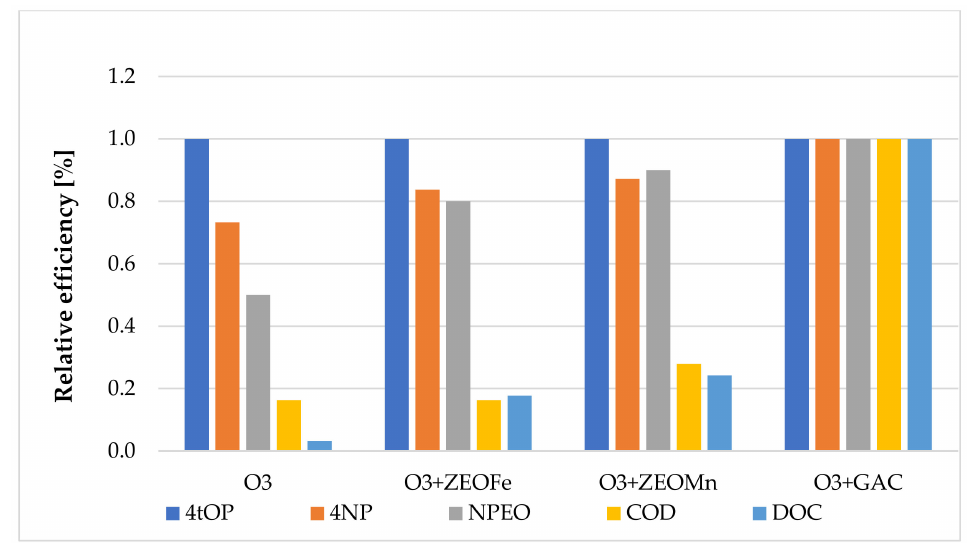
Figure 5. Relative efficiencies of several applied AOPs related to the O 3 /GAC process [192]. Adsorptive ozonation with O 3 /GAC was the most efficient method and showed high potential for the practical use on the basis of not only the comparison of AP and APEO concentrations, as well as COD and TOC values, but also the ecotoxicity and cytotoxicity of the samples, as well as the respirometric measurements with activated sludge. Other studied methods also revealed a significant decrease in all examined pollution